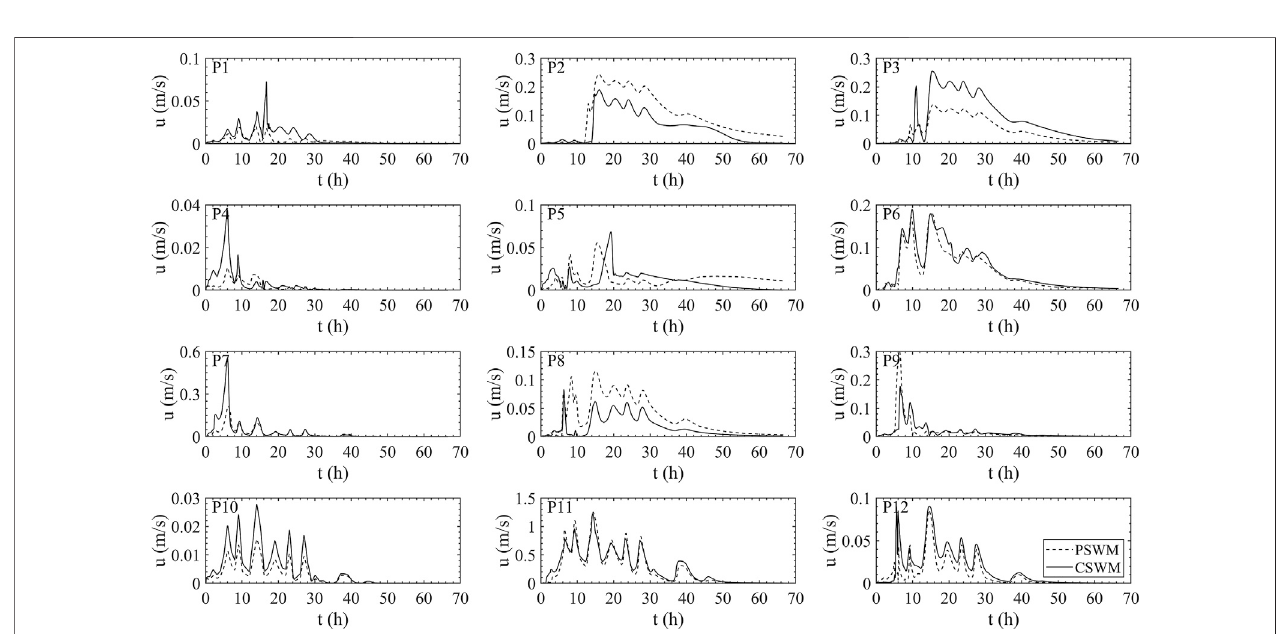
FIGURE 10 | Temporal evolution of fl ow velocity at 12 selected points for PSWM and CSWM.